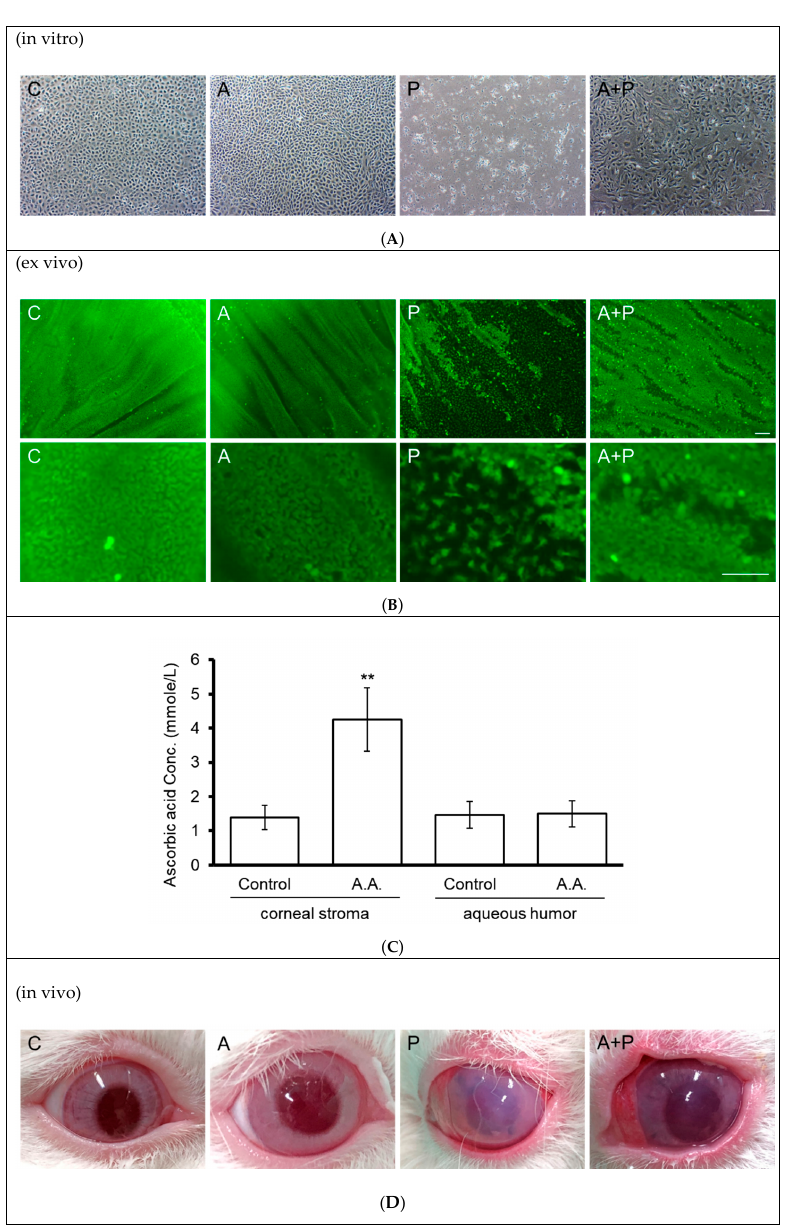
Figure 5. E ff ect of topical ascorbic acid on oxidative stress-induced corneal endothelial damage in a rabbit model. ( A ) Primary rabbit corneal endothelial cells (in vitro) were cultivated in medium with (A and A + P groups) or without (C and P groups) addition of 1 mM of ascorbic acid for two days, followed by addition of paraquat (0.2 mM) in the paraquat-treated groups (P and A + P groups) for five days. Sloughing of corneal endothelial cells was observed under phase-contrast microscopy. ( B ) Rabbit corneal tissue specimens (ex vivo) were cultivated in medium with (A and A + P groups) or without 1 mM of ascorbic acid for two days, followed by the addition of paraquat (25 mM) to the P and A + P groups for 15 min. Two days later, the sloughing of corneal endothelial cells was observed using Calcein-AM stain. ( C ) Rabbit corneas (in vivo) received an application of ascorbic acid (284 mmol / L in BSS solution) or BSS alone for two days (three times per day). After di ff usion, ascorbic acid concentrations in the corneal stroma and anterior chambers were examined using the FRASC assay. ( n = 3, ** p < 0.01). ( D ) Rabbit corneas (in vivo) received an application of ascorbic acid (284 mmol / L in BSS solution) or BSS alone for two days (three times per day), followed by intracameral injection of 25 mM paraquat (diluted in BSS) or BSS alone for 15 min. Corneal transparency was assessed using external eye photography on day two. (The scale bar represents 100 µ